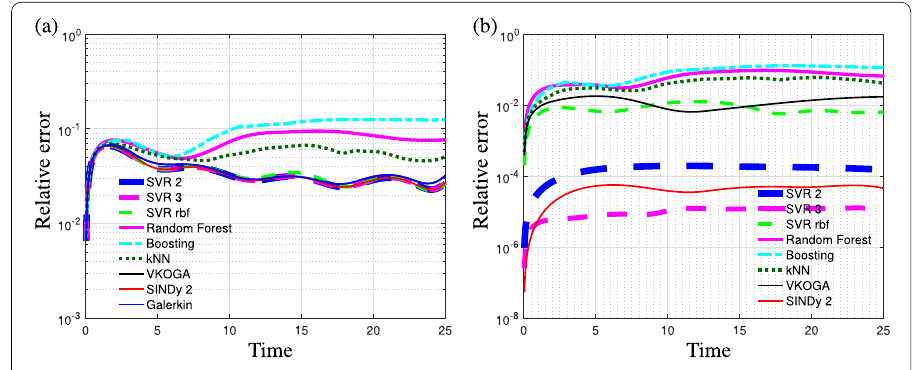
Fig. 2 Backward Euler for 1D inviscid Burgers’ equation: time evolution of relative error: a e FOM ( t ) in FOM; and